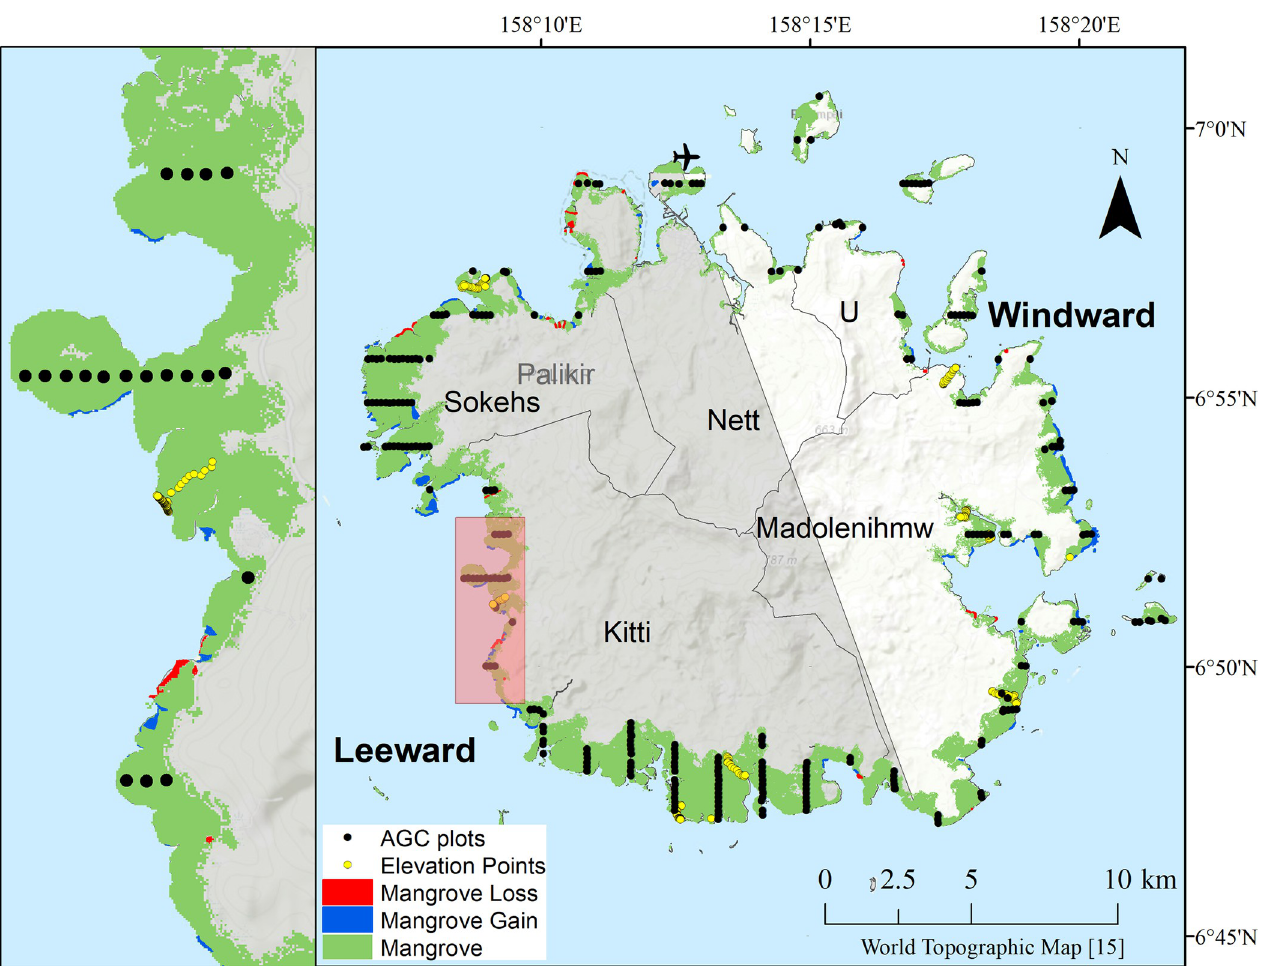
Fig 1. Mangrove area. Map of Pohnpei Island (right) and an insert for a portion of the island (left), showing areas of mangrove change (loss in red, gain in blue, and unchanged area in green) between 1983 and 2018 in 3 meter resolution. Locations of aboveground carbon (AGC) field survey plots; elevation points; municipality names; windward and leeward island sides (translucent white and grey, respectively); Pohnpei International Airport; and Palikir, the capitol of Federated States of Micronesia (FSM) are also shown on Esri’s topographic basemap [15]. In total, mangrove cover was 6,377 ha in 1983 and 6,426 ha in 2018, with a net change of plus 49 ha (loss 16, gain 65